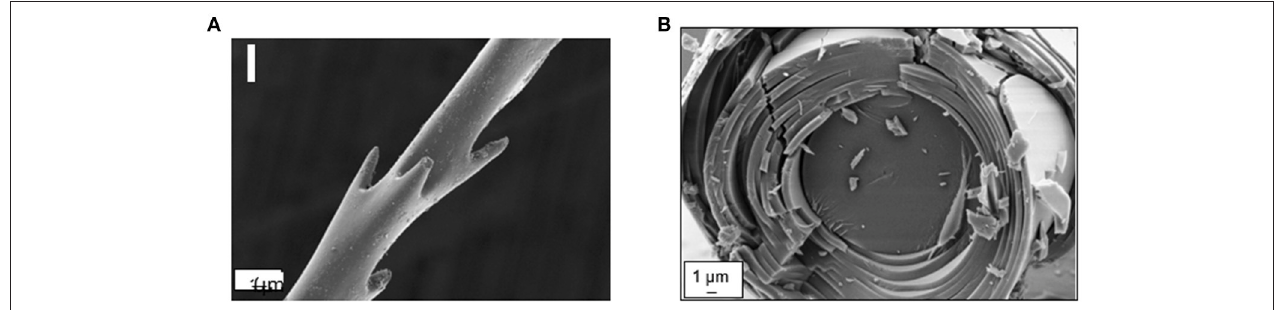
FIGURE 2 | (A) Cross-section Scanning Electron Microscopy image of Euplectella aspergilium spicule. (B) Zoomed SEM image on spicule’s edge showing part of the core region and the concentric silica layers. The multilayer set (silica + organic) surrounding the core of the spicule, forms a homogeneous medium of an effective refractive index different from spicule core refractive